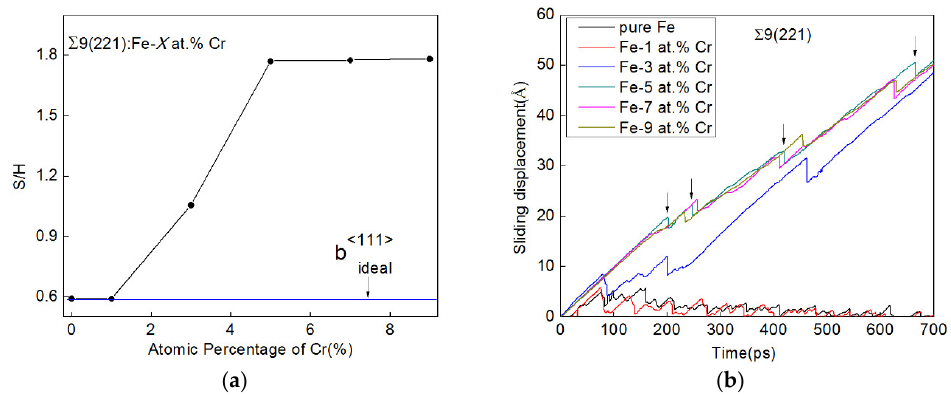
Figure 5. ( a ) Values of S/H and ( b )sliding displacement-time curves of the Σ9(221) GBs in pure Fe and Fe-X at.% Cr alloys (X = 1, 3, 5, 7, and 9).